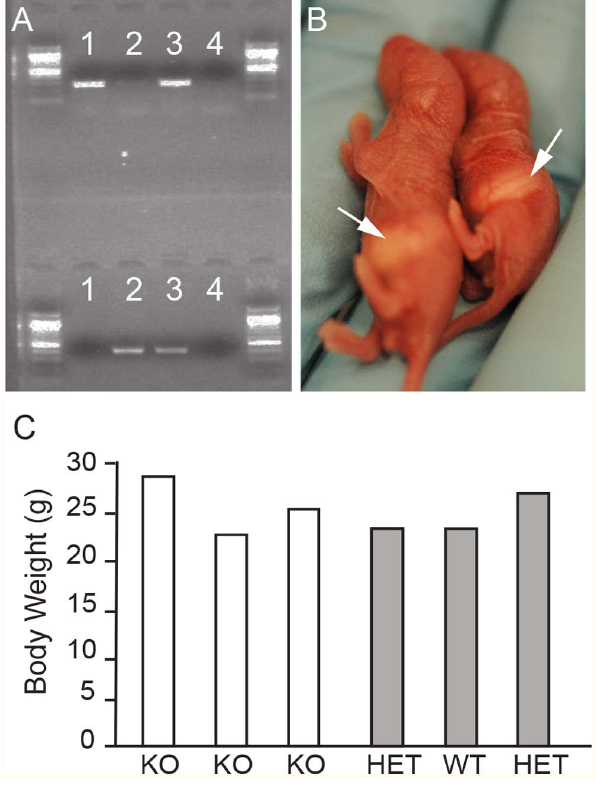
Figure 1. Genotyping and phenotyping of global Nav1.7 knockout animals. A . Example of endogenous (top - 267 bp) and targeted (bottom - 389 bp) PCR products obtained from DNA isolated from Nav1.7 WT (lane 1), KO (lane 2) and HET (lane 3) animals, while the last lane serves as a negative control (no DNA). All PCRs were run using a 1 kb PLUS DNA ladder. B. Photos of postnatal day 2 littermates showing their capability in feeding naturally by the presence of milk spots in control (see arrow left) and KO (see arrow right) and slight size difference in young animals. C. Body weight (grams) comparison between six female littermates at nine weeks of age that represented all three genotype classes illustrating the absence of size difference in adult